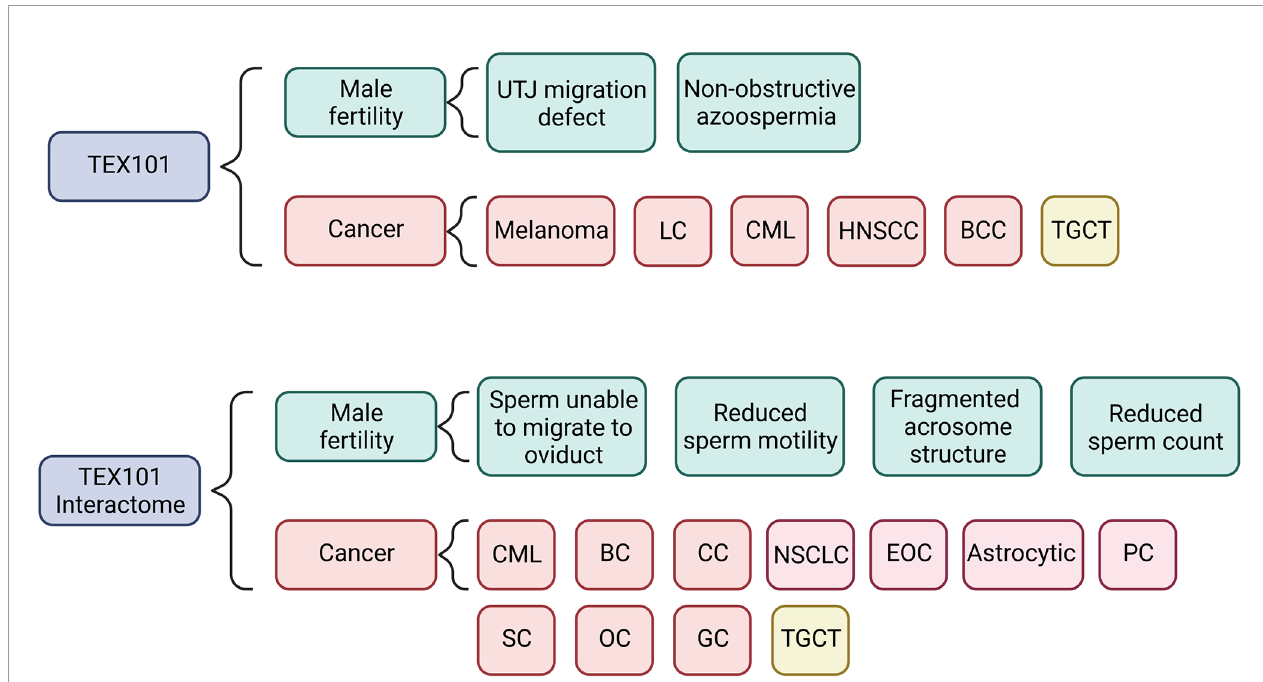
FIGURE 2 | Summary of results for both the TEX101 and the TEX101 interactome literature and database search showing the mechanisms and types of cancer that the respective genes and proteins are involved in. Azoospermia refers to the absence of sperm in ejaculate. LC, Lung Cancer; CML, Chronic Myeloid Leukaemia; HNSCC, Head and Neck Squamous Cell Carcinoma; BCC, Basal Cell Carcinoma; TGCT, Testicular Germ Cell Tumour; CC, Colon Cancer; NSCLC, Non-Small Cell Lung Cancer; EOC, Epithelial Ovarian Cancer; PC, Prostate Cancer; SC, Skin Cancer; OC, Oesophageal Cancer; GC, Gastric